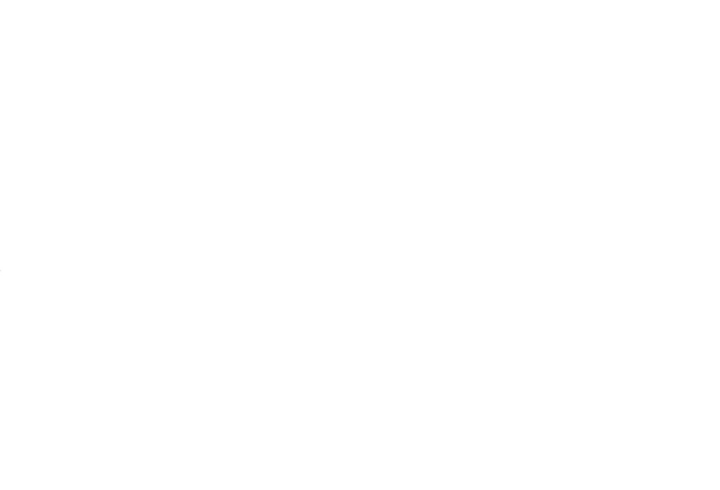
State anxiety as measured by the STAI-S is depicted in Figure 4. Both groups report